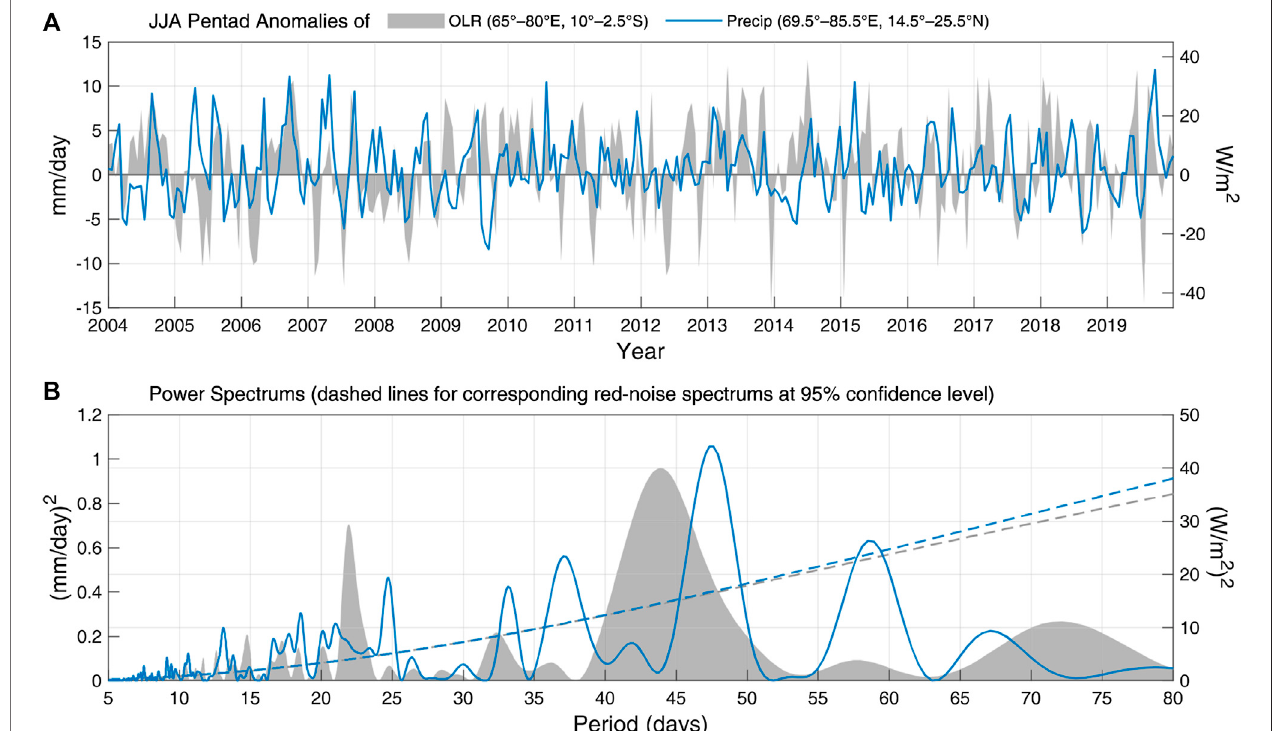
FIGURE 2 | (A) Pentad anomalies of OLR over southwestern equatorial Indian Ocean (60 ° – 85 ° E, 10 ° – 2.5 ° S, gray area), and precipitation over northern Peninsular India (69.5 ° – 85.5 ° E, 14.5 ° – 25.5 ° N, blue line) during 2004 – 2019 JJA. (B) Power spectrums of the time-series in (A) and the corresponding red-noise spectrums at 95% con fi dence level (denoted by dashed